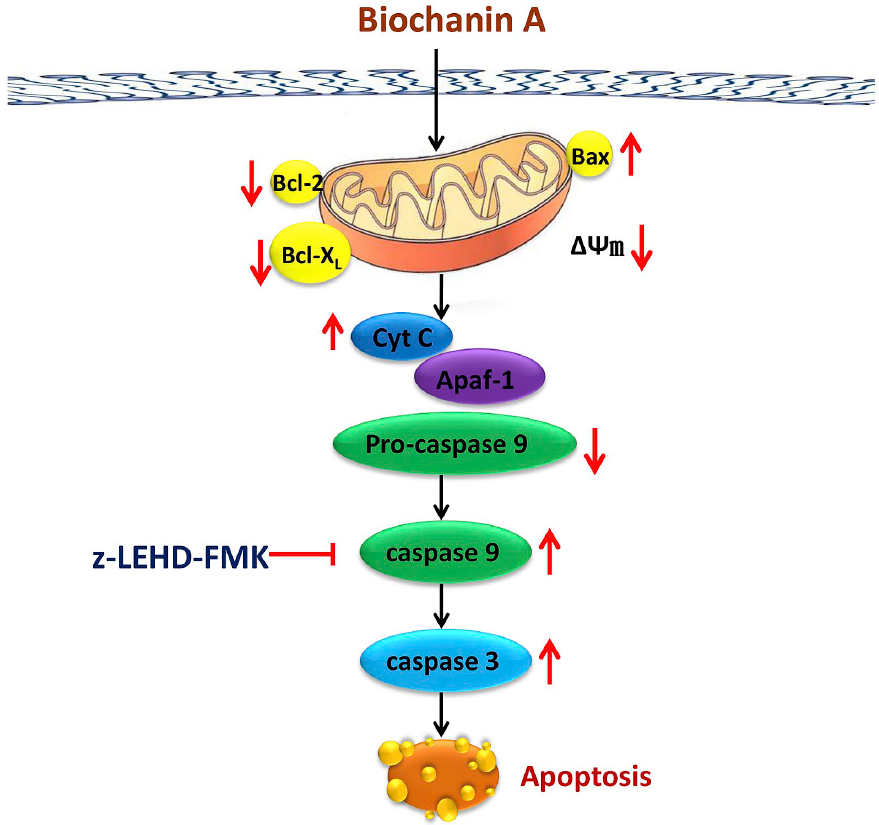
Figure 4. Mechanism of apoptosis of osteosarcoma cells induced by BCA. Abbreviations: Bcl-2, B- cell CLL/lymphoma 2; Bax, Bcl- 2 associated X; Δψm, mitochondrial membrane potential; Cyt C, cytochrome c; Apaf-1, apoptotic protease-activating factor-1; The upwards arrows represent upregulation; The downwards arrows represent downregulation. Reprinted with permission from Ref. [7].